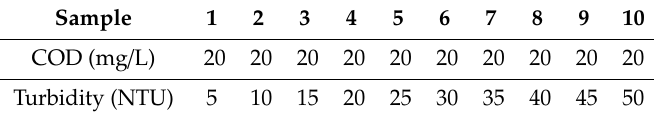
Table 8. The COD and turbidity values of ten samples.